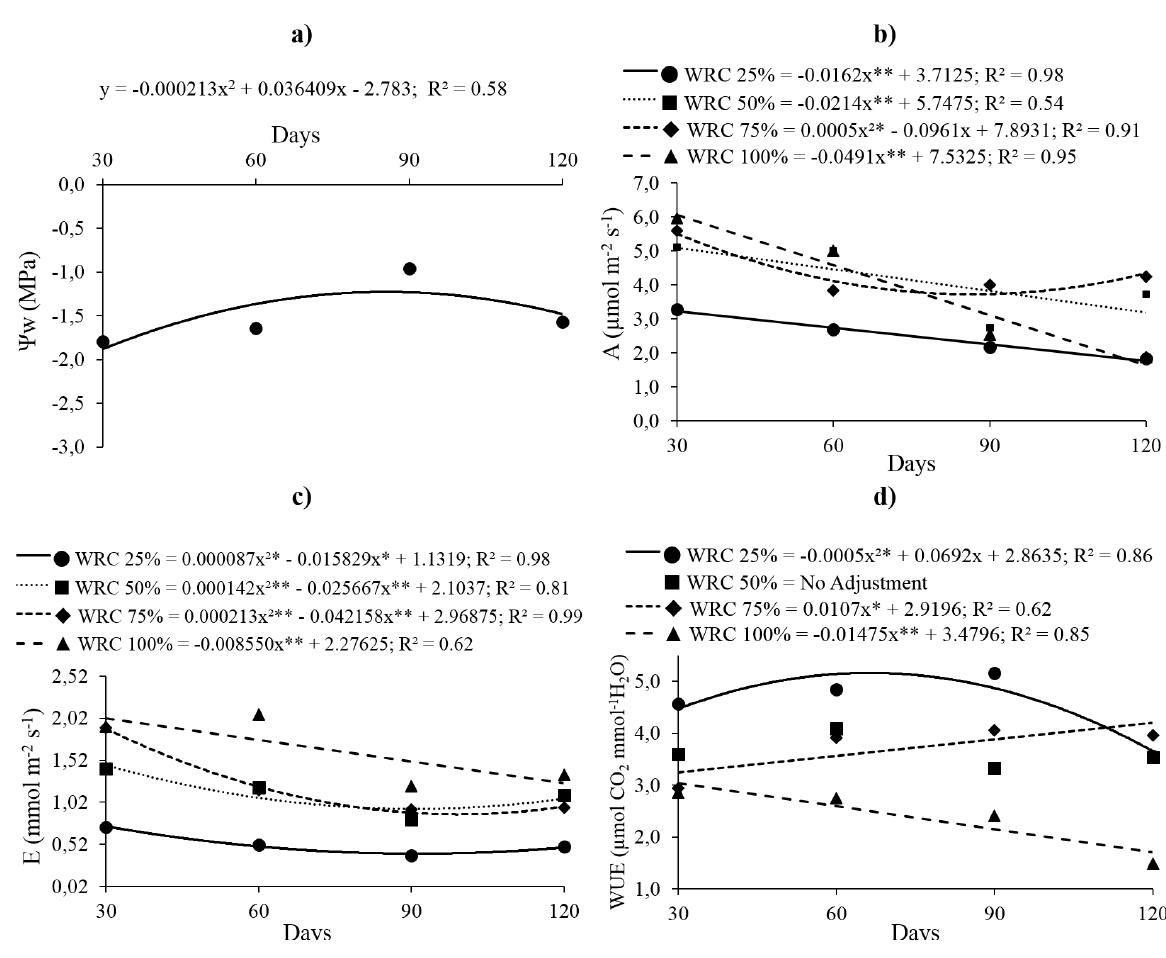
Figure 2 - Water potential of the leaves – Ψw ( a ) liquid photosynthesis - A ( b ); transpiration - E ( c ) and water use efficiency - WUE ( d ) in Copaifera langsdorffii Desf. depending on different water retention capacity (WRC) and